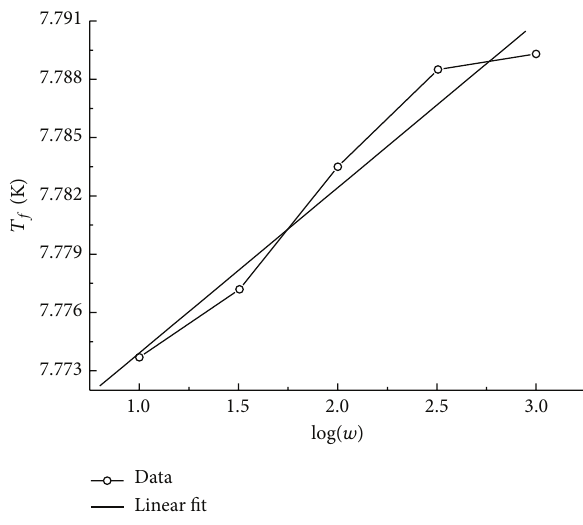
Figure 12: The log (𝑤) dependence of the 𝑇 𝑓 .